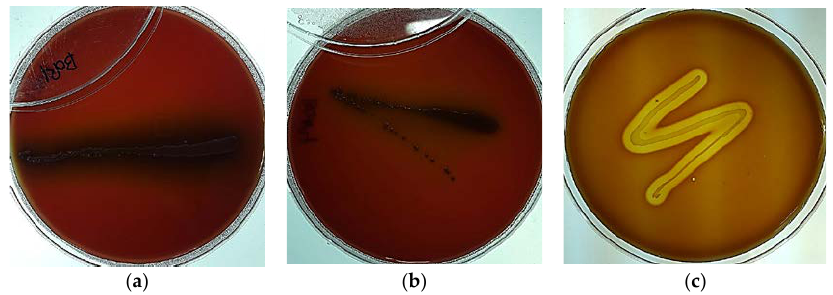
Figure 1. B. bifidum BGN4 (( a ); back light) and B. longum BORI (( b ); back light) growth with no blood cell lysis. Complete lysis of red blood cells was observed, with clear zones around the Listeria ivanovii subsp. ivanovii ATCC 19119 colonies (( c ); positive control, back light).